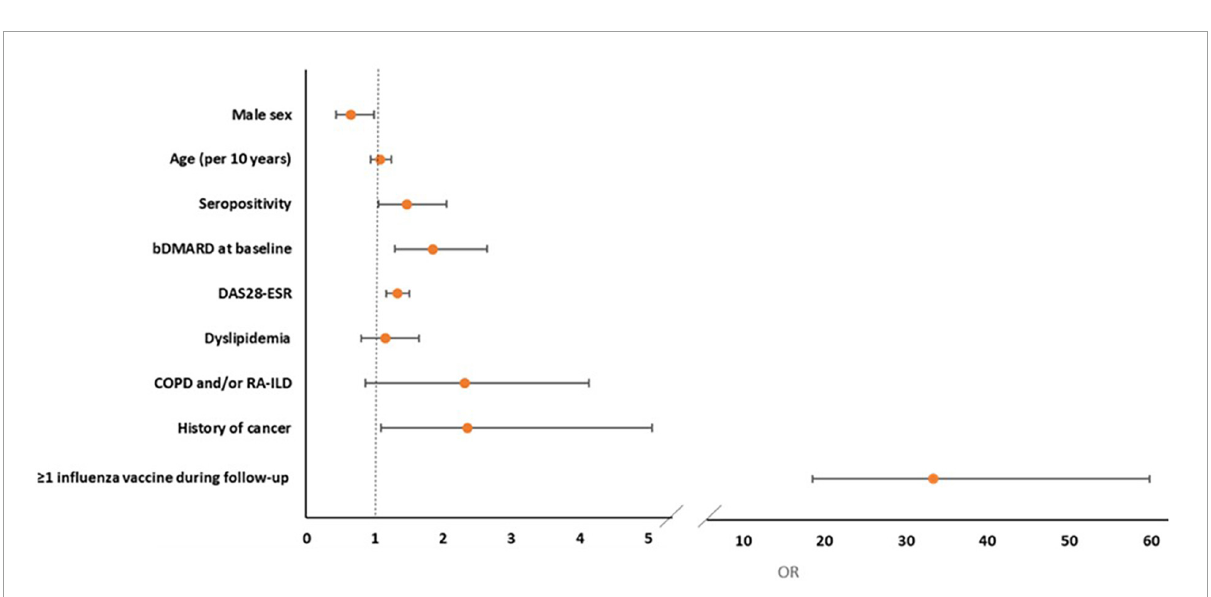
FIGURE2 Forest plot of multivariate logistic regression analysis of factors associated with the prescription of pneumococcal vaccine during follow-up.